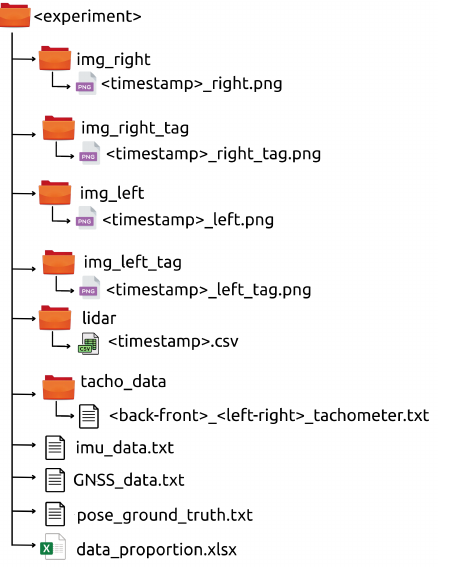
Figure 22. Human-readable contents of an experiment in the